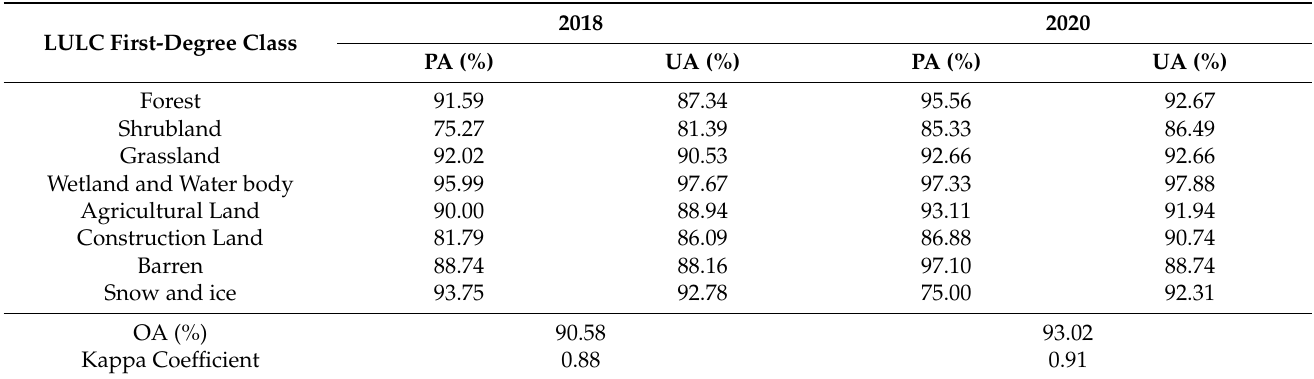
Table 4. The confusion matrix of LULC first-degree class accuracy (PA: producer’s accuracy; UA: user’s accuracy; OA: overall accuracy).